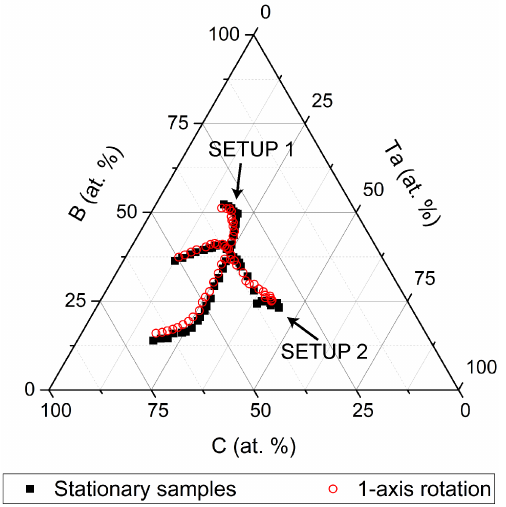
Figure 4. Ternary diagram of the deposited